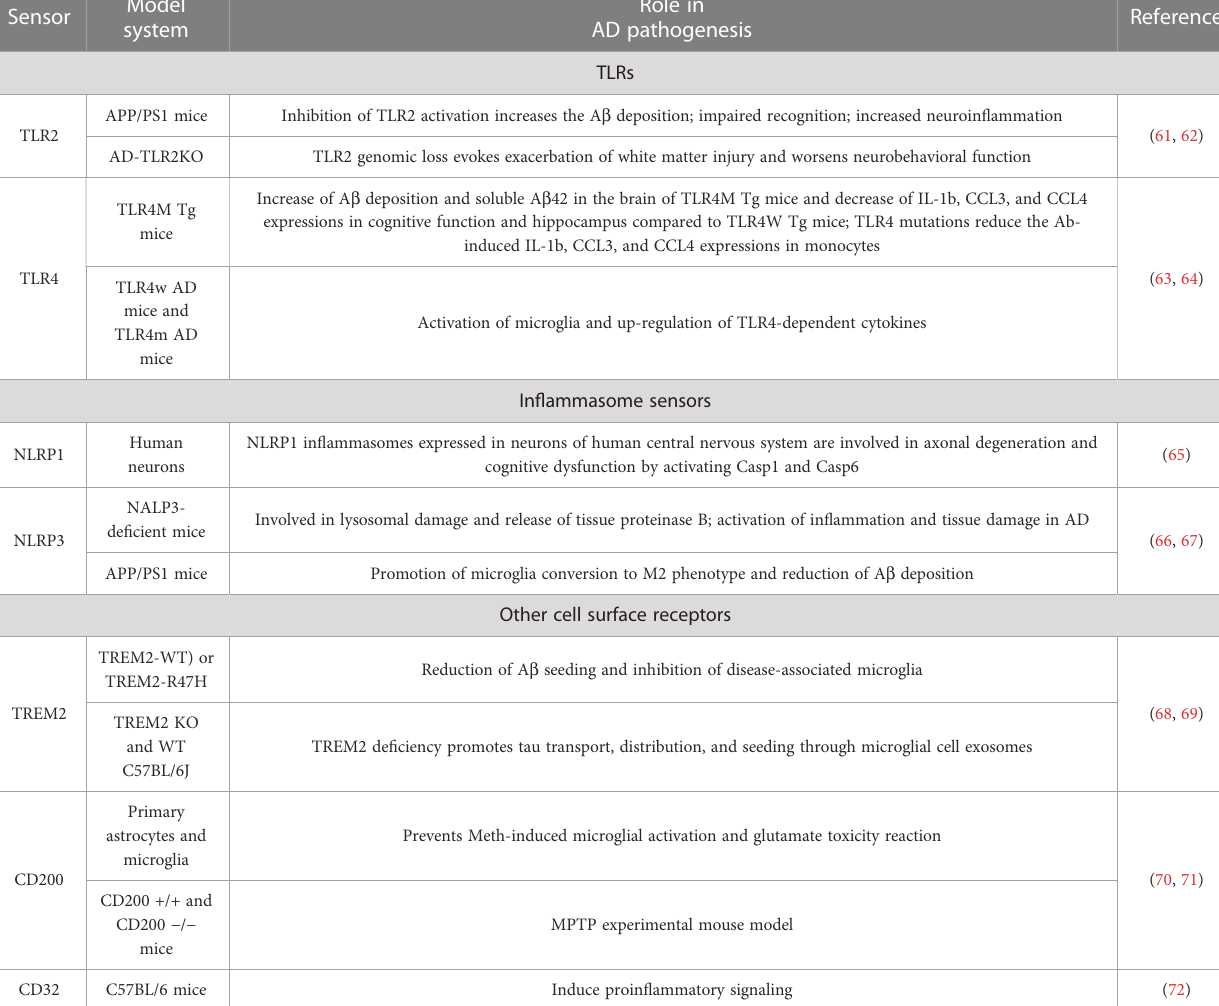
TABLE 1 Microglia receptors associated with Alzheimer ’ s disease (AD).